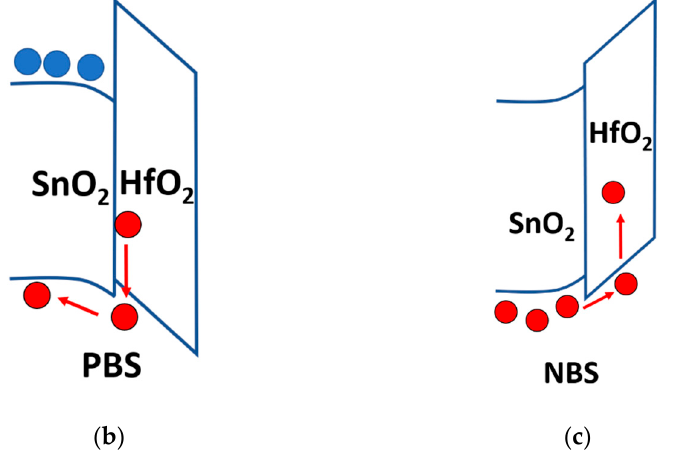
Figure 6. Band offsets of polycrystalline SnO 2 and HfO 2 . ( a ) Measured band offsets by XPS, ( b ) hole injection into the SnO 2 layer under PBS, ( c ) hole injection into the HfO 2 layer under NBS.